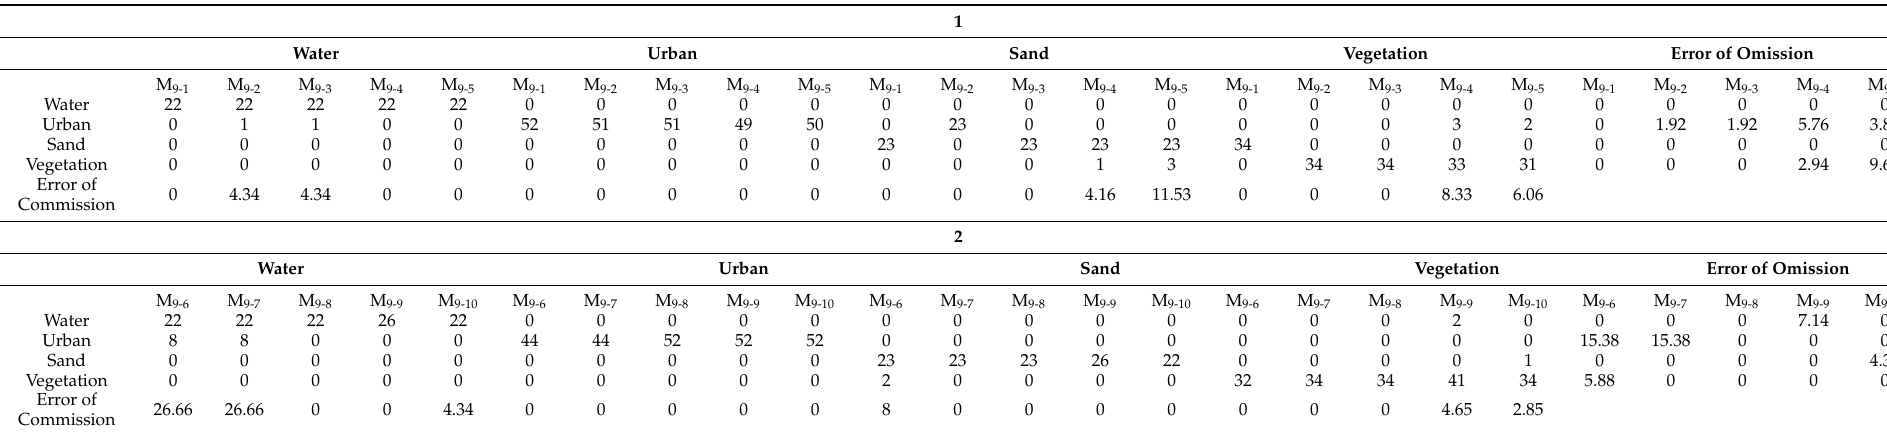
Table 4. 1. Confusion matrix of one-to-five-fold cross-validation. 2. Confusion matrix of six-to-ten-fold cross-validation.